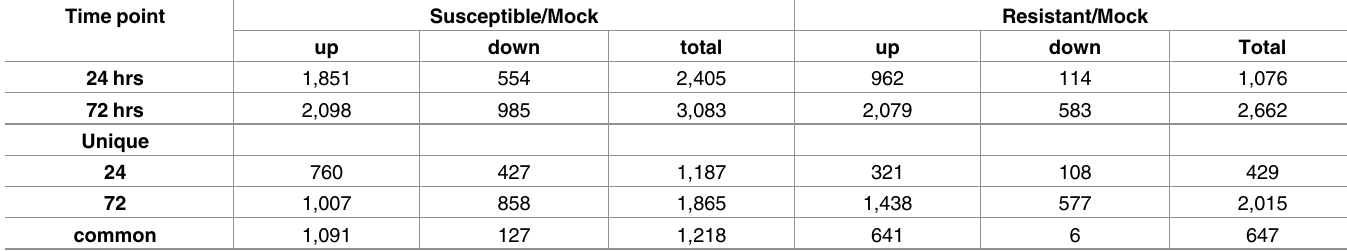
Table 1. Counts of differentially expressedgenes in cv.